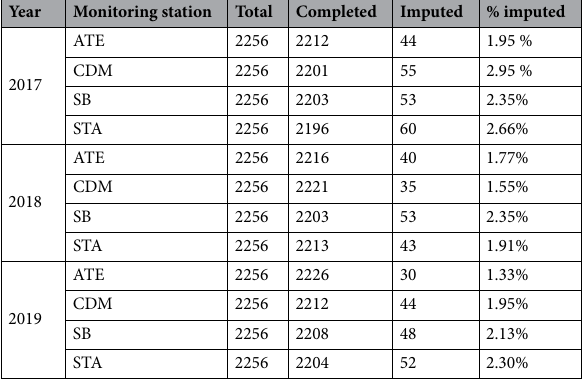
Table 1. Percentage of imputation for each monitoring station during the years 2017, 2018 and 2019. This analysis is based on the 2256 observations obtained from the winter season.